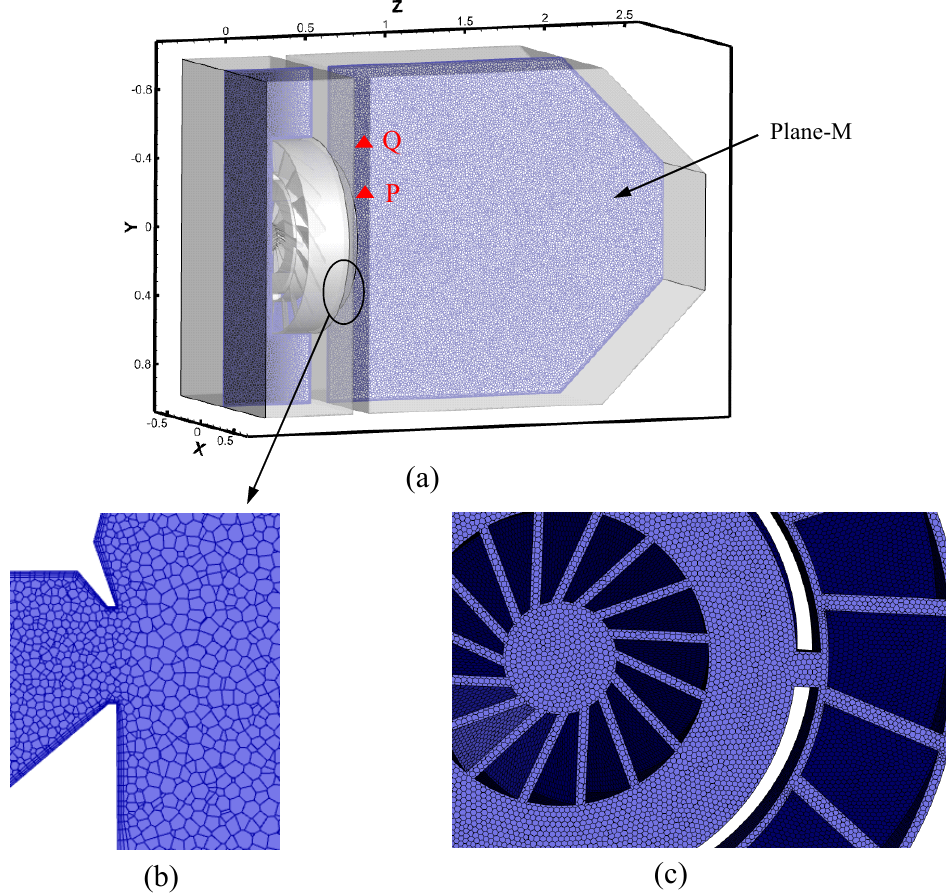
Figure 2. Grid distributions. ( a ) Computational grid, ( b ) grid around the swirler outlet, and ( c ) grid on the surface of swirler.